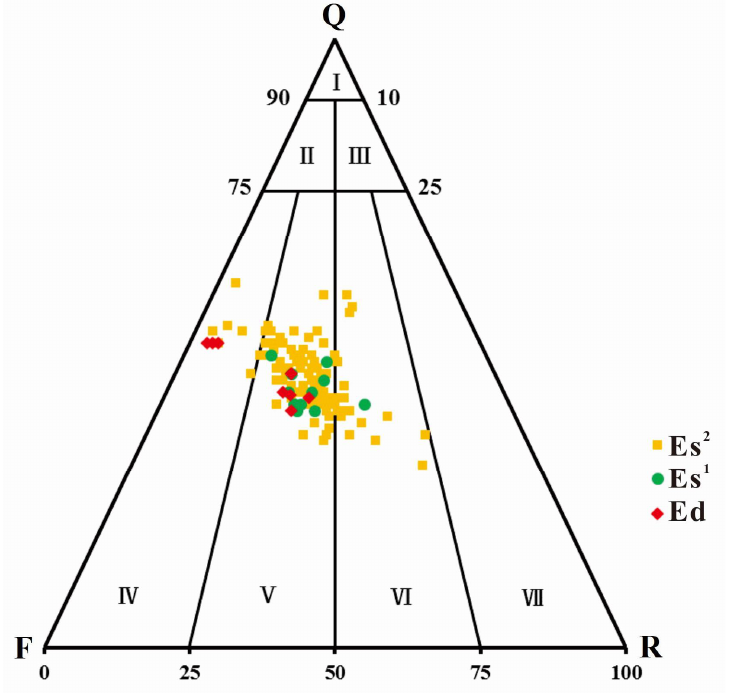
Figure 4. Triangular plot of the rock type. Es 2 , Es 1 , and Ed in the diagram represent stratigraphic intervals. Q = quartz; F = feldspars; R = rock fragment. I—quartz sandstone; II—feldspar quartz sandstone; III—lithic quartz sandstone; IV—feldspar sandstone; V—lithic feldspathic sandstone; VI—feldspathic lithic sandstone; and VII—lithic sandstone.